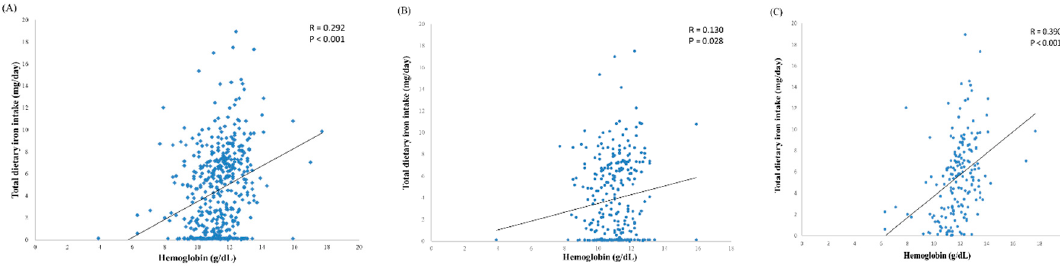
Figure 2. Correlations between total dietary iron intake and hemoglobin at 1 – 12 months ( A ), 1 – 6 months ( B ) and 7 – 12 months ( C ).